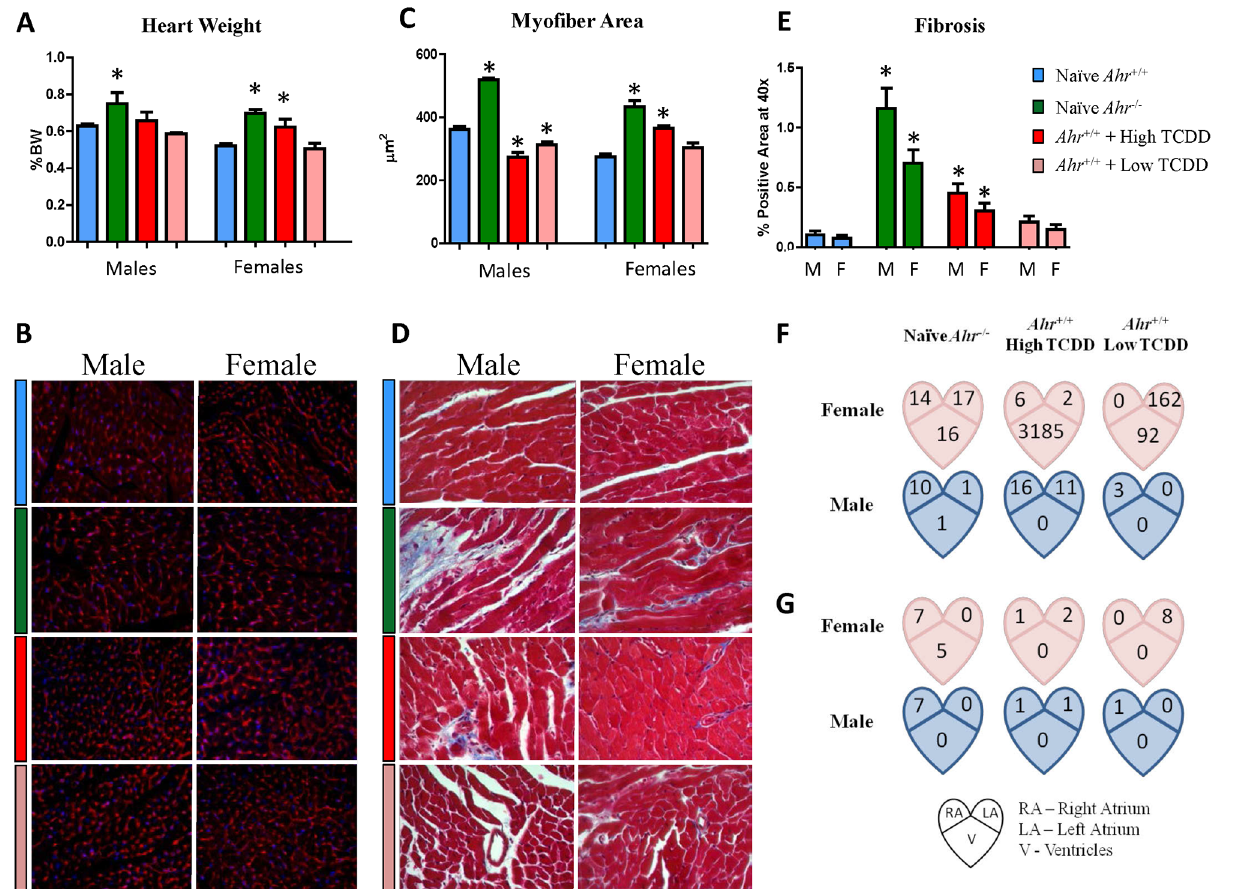
Fig 2. In utero disruption of AHR signaling affects adult heart structure and transcriptome. (A) Heart weights (normalized to body weight) at necropsy (10 months of age, PND 300)) from na ï ve Ahr +/+ and Ahr -/- and high and low dose AHR-ligand exposed mice. Wheat germ agglutinin (B) staining of 5- μ m sections were used to highlight the cross-sectional myofibers profiles which were used to ascertain the myofiber cross-sectional area (C), which are expressed as means ± minimum and maximal measured areas. Nuclei are stained in blue by DAPI-counterstain; 40X objective. Masson ’ s trichrome staining (D) was used to highlight the myocardial extracellular matrix as a proxy for fibrosis (E); 40X objective. (F) Number of differentially expressed genes in the adult heart as a consequence of AHR disruption in utero , from Ahr -/- and TCDD-exposed Ahr +/+ right atrium (RA), left atrium (LA), and ventricle (V) tissue from males and females. (G) Compartment-specific number of persistent genes (i.e. differentially expressed in the embryo heart and in the adult heart).